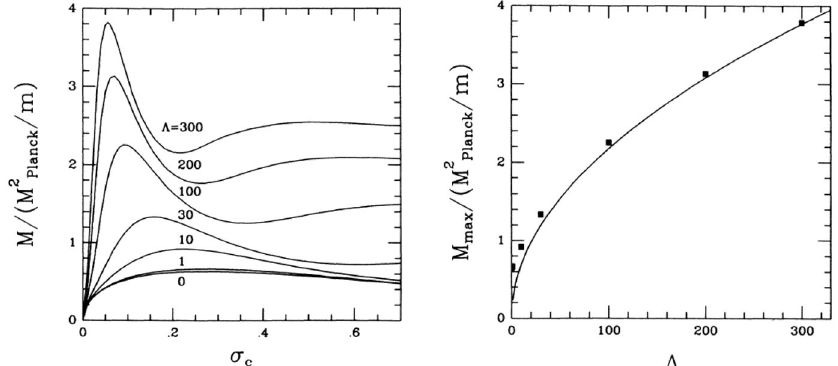
Fig. 3 Left : The mass of the boson star as a function of the central value of the scalar fi eld in adimensional ffiffiffiffiffiffiffiffiffiffi p / c . Right : Maximum mass as a function of K (squares) and the asymptotic K ! 1 units r c ¼ 4 p G relation of Eq. (52) (solid curve). Reproduced with permission from Colpi et al. (1986), copyright by